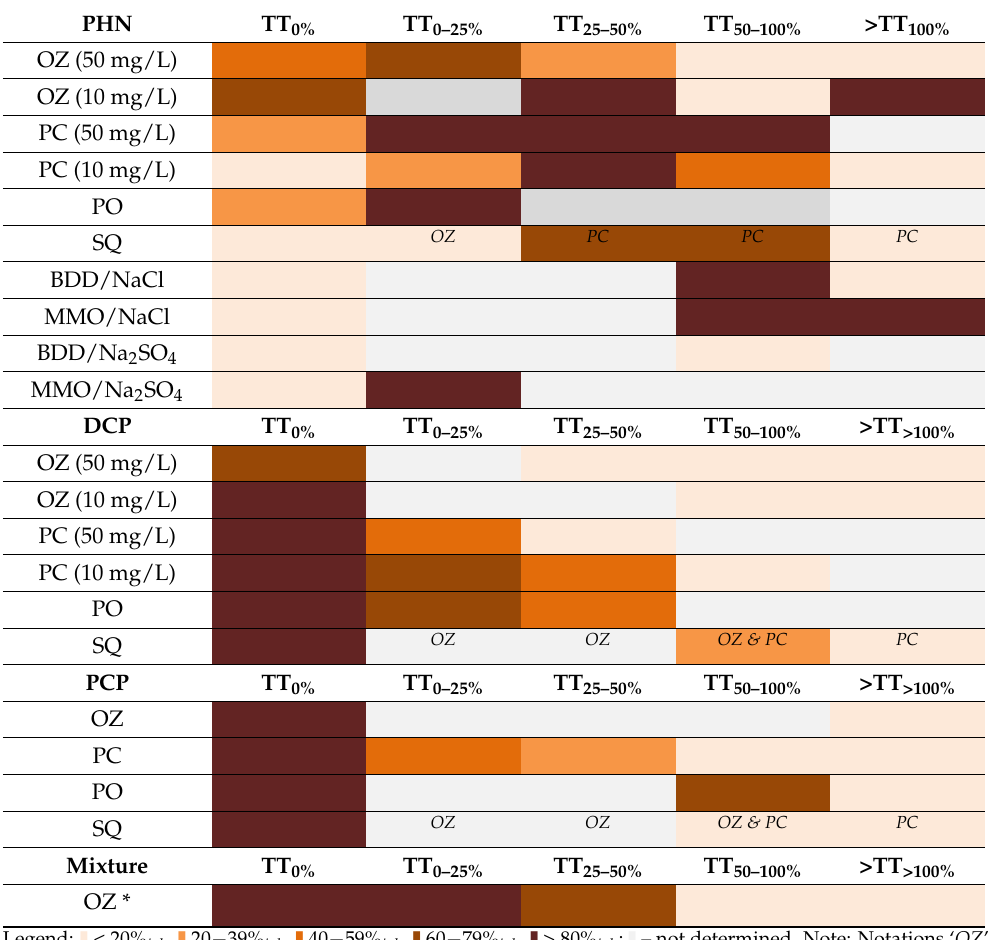
Table 3. Comparison of the inhibition (% inh ) on D. magna organisms (i.e., detoxification extent; see Equation (6) in Section 2.4) of treated phenol (PHN), 2,4-dichlorophenol (DCP), pentachlorophenol (PCP), and mixture solutions with ozonation (OZ), photocatalysis (PC), photooxidation (PO), sequen- tial method (SQ) and electrooxidation with BDD and MMO in NaCl and N 2 SO 4 at different treatment times